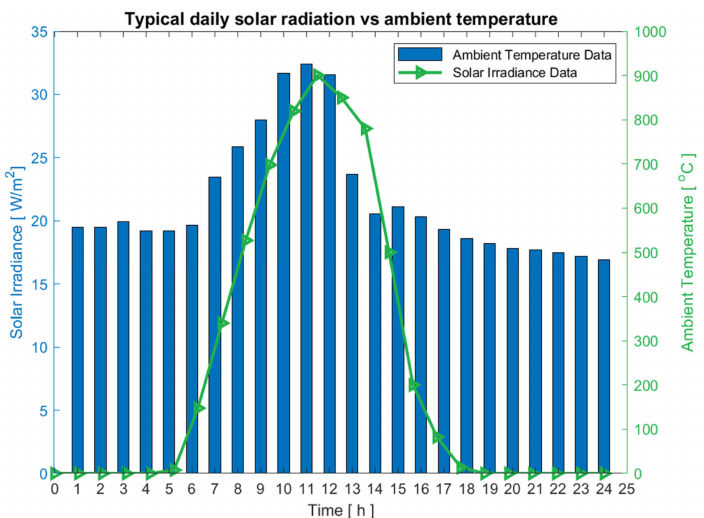
Figure 4. A real-time daily solar radiation and ambient temperature data on a typical summer day in